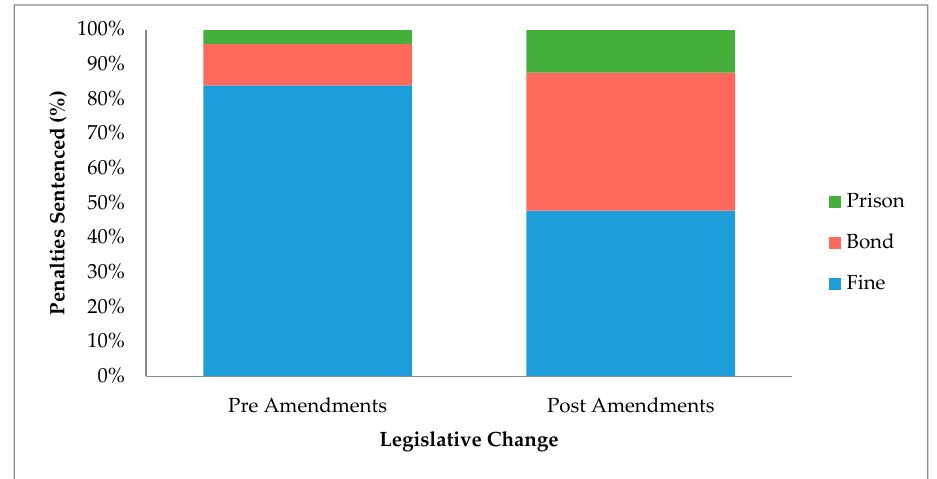
Figure 2. Percentage of penalties sentenced under section 13 of the AWA before and after the 2008